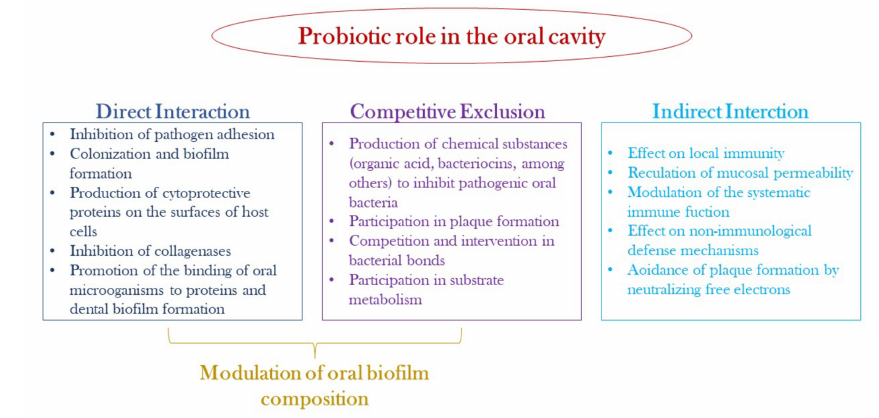
Figure 4. Possible mechanisms of probiotic action in the oral cavity.